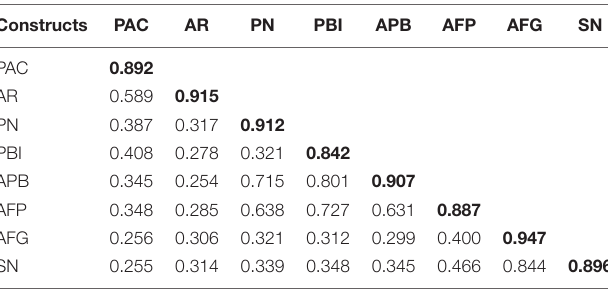
TABLE 3 | Correlations and values of square root of AVE among model constructs.